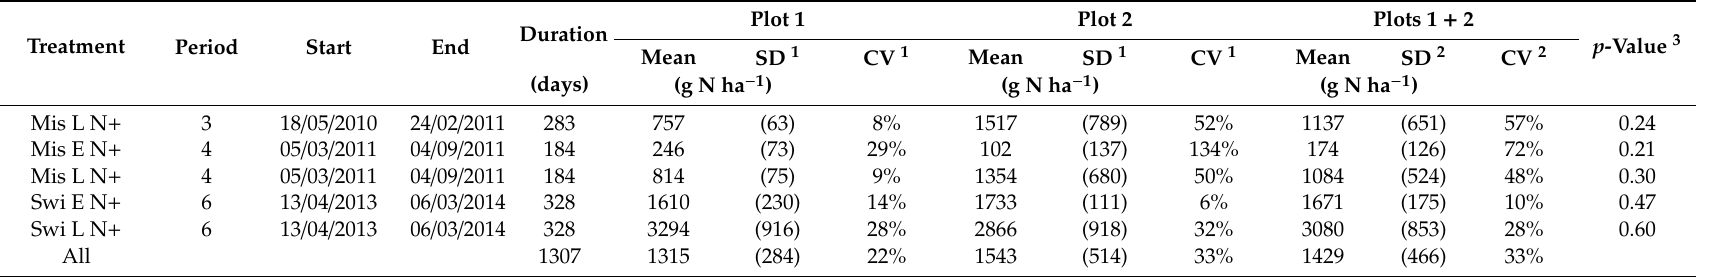
1 Intra-plot variability. 2 Intra- and inter-plot variability. 3 Comparison of means between Plots 1 and 2 (Student